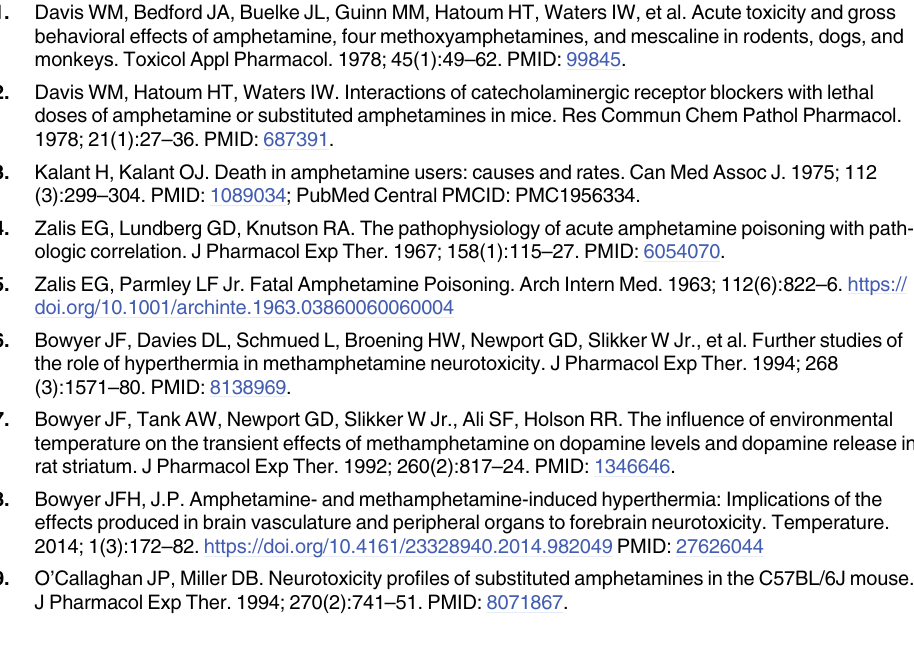
S8 Table. Fold-change in mRNAs of whole blood from AMPH normo, AMPH hyper, and EIH relative to control, as assessed by RNA-seq and RT-qPCR. Data are presented as mean fold-change relative to control. � , p < 0.05. S9 Table. The top 245 transcripts with the greatest fold-change in the AMPH hyper group relative to the control group. S10 Table. Fold-change in miRNAs in the whole blood of AMPH normo, AMPH hyper, and EIH groups relative to control, as assessed by TLDA cards or RNAseq (AMPH hyper only). Data are presented as mean fold-change relative to control. � p < 0.05. S11 Table. List of mature miRNA detected by small RNAseq